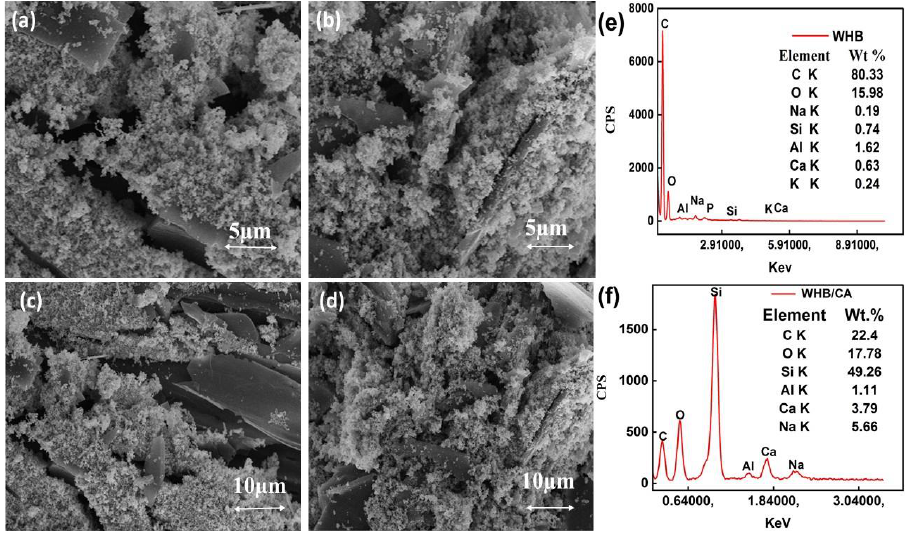
Figure 1. SEM of WHB ( a , c ) and WHB/CA ( b , d ), EDS of WHB ( e ), and EDS of MWH/CA ( f ).